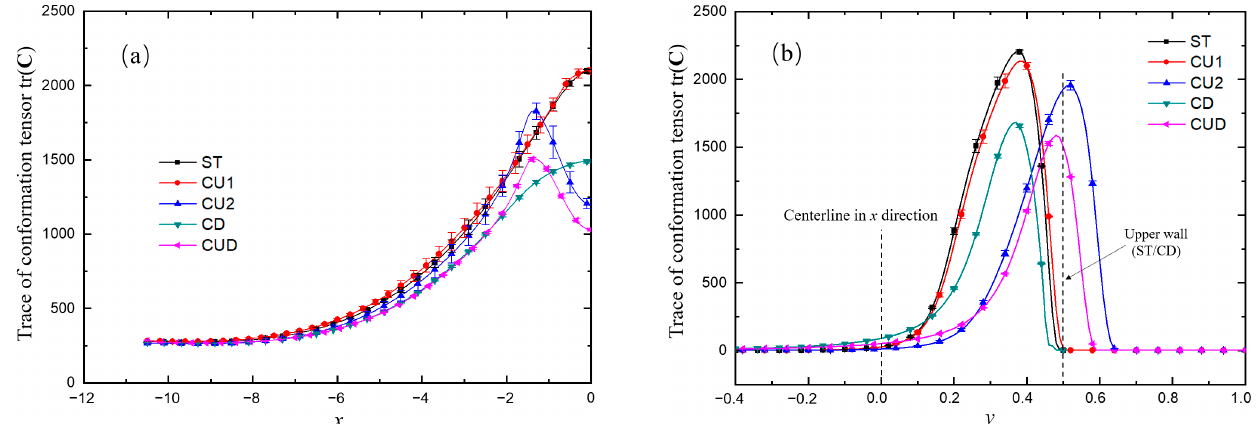
Figure 11. Variation trends of the time-averaged trace of conformation tensor tr( C ) along the lines of ( a ) y = 0.4 and ( b ) x = 0. For all cases, 𝛽 = 0.5 , Wi = 5 .